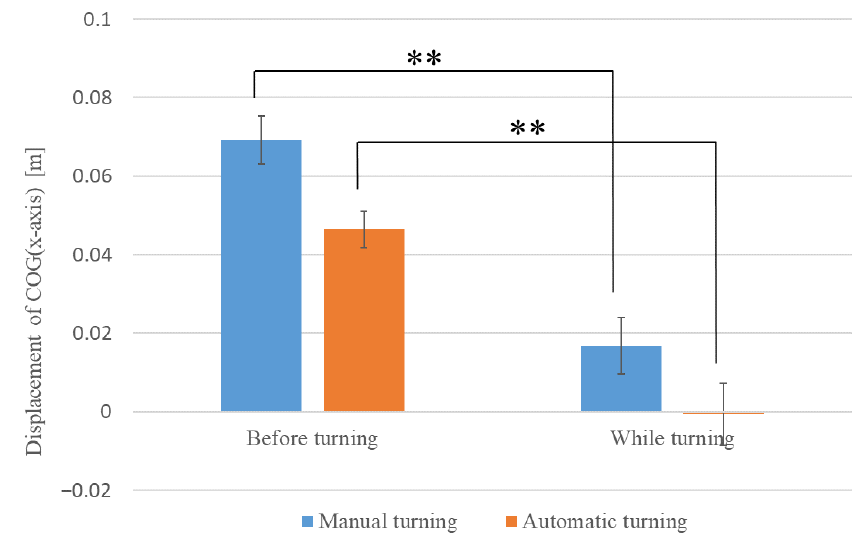
Figure 7. Average values of COG ( x -axis) before and after turning.